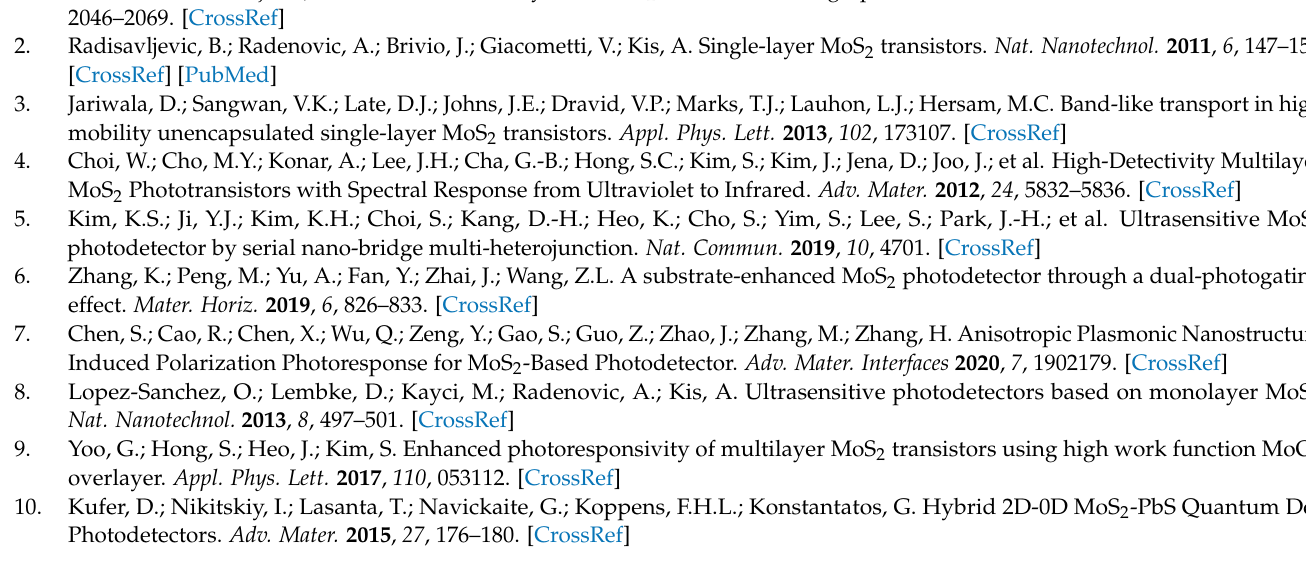
the laser power. Figure S3: The relationship between the I ph and the laser power of the pristine MoS 2 photodetector. Figure S4: XPS spectra of Mo 3d and S 2s core levels of (a) as-prepared and (b) oxygen- plasma treated MoS 2 . Figure S5: Transfer characteristics of the treated device in a semi-logarithmic coordinate. Figure S6: XPS spectra of O 1s core levels of pristine and oxygen-plasma treated MoS 2 . Figure S7: Schematic of MoS 2 [O 2 ] x superlattices